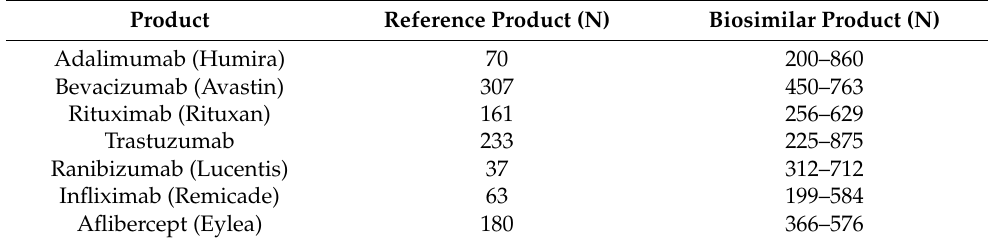
Table 2. Number of subjects in clinical studies of biosimilars compared to the originator study (www.clinicaltrials.gov (accessed on 1 July 2022)). (References [95–101] report the values for the reference